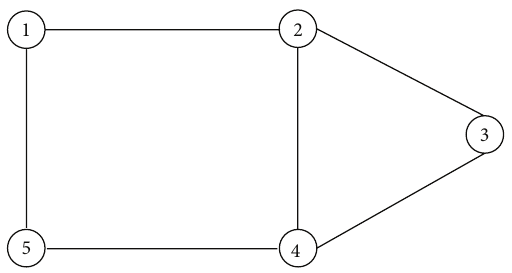
Figure 1: The topology of wireless sensor